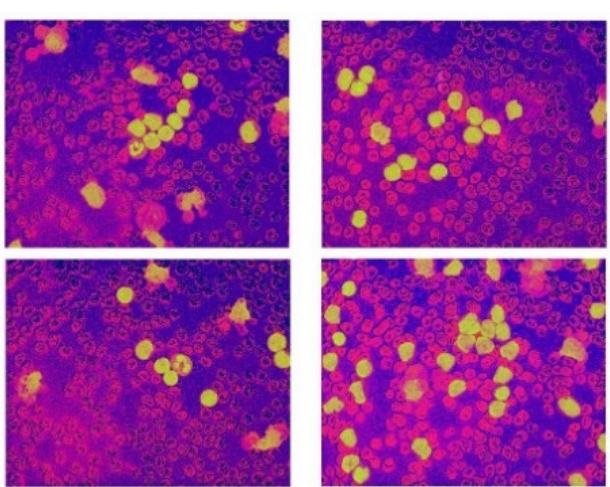
Figure 2. Original images.